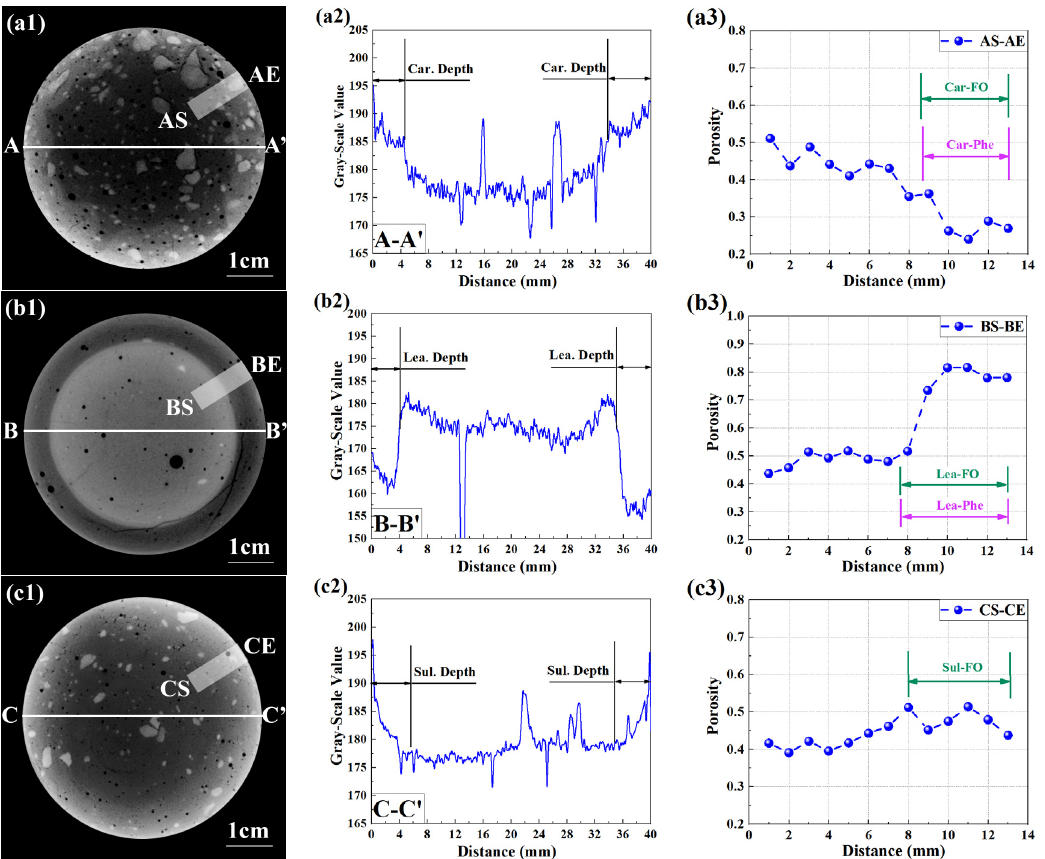
Figure 7. Neutralized regions based on CT and XRAM. ‘ a ’, ‘ b ’, and ‘ c ’ stand for partly carbonated, leached, and sulfate-attacked sample, respectively; suffix ‘ 1 ’ stands for the rendered cross-section based on CT; suffix ‘ 2 ’ and ‘ 3 ’ stand, respectively, for the 1D grayscale value and 1D porosity distribution. FO: F. orchid indicator; Phe: phenolphthalein.